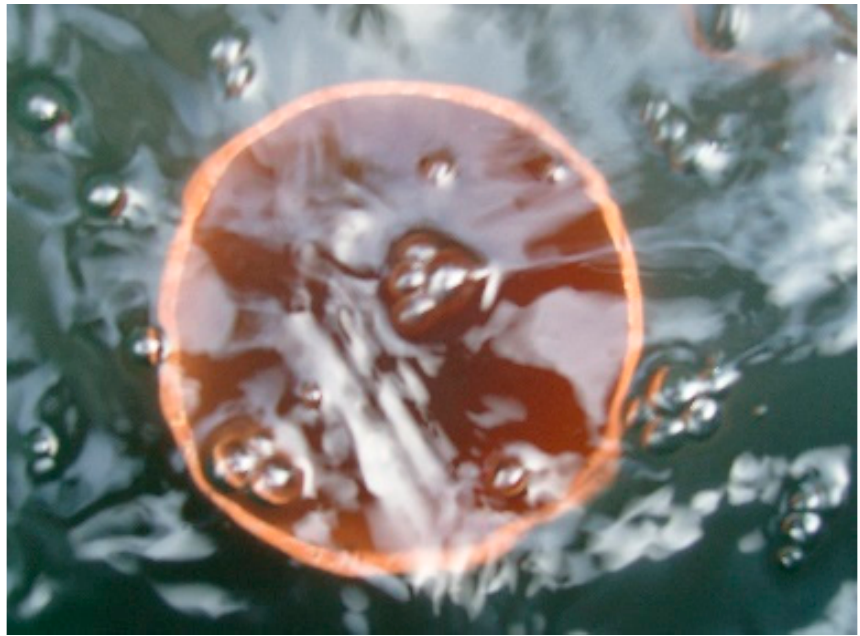
Figure 4. Example of the cartridge holder used in the reactor, its placement in the reactor, and its interaction with the water body.